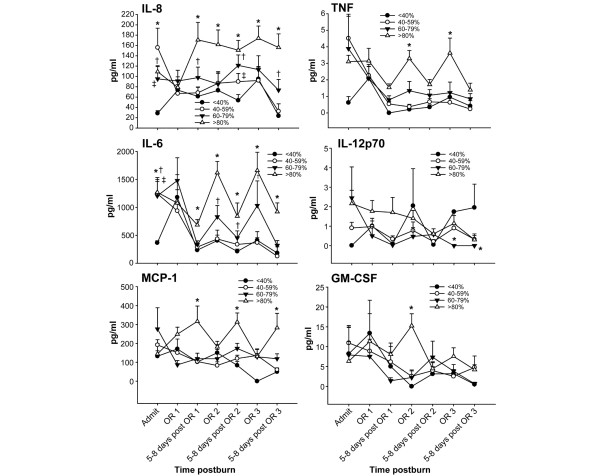
Cytokine concentrations in relation to acute hospitalization. Cytokines were measured at admission (Admit), at first surgery (OR1), at 5–8 days postsurgery 1, at second surgery (OR2), at 5–8 days postsurgery 2, at third surgery (OR3), and again at 5–8 days postsurgery 3. Six cytokines out of 17 measured were significantly different between different burn sizes. Serum IL-8, TNF, IL-6, IL-12p70, monocyte chemoattractant protein-1 (MCP-1) and granulocyte–macrophage colony-stimulating factor (GM-CSF) were significantly increased in the large burns compared with the other three groups. *Significant difference between >80% TBSA burn group versus 60–79%, 40–59% and <40% TBSA burn groups, P < 0.05. †Significant difference between 60–79% TBSA burn group versus 40–79% and <40% TBSA burn groups, P < 0.05. ‡Significant difference between 40–59% TBSA burn group versus <40% TBSA burn group, P < 0.05. Normal levels: IL-8, 7.6 ± 3.9 pg/ml; TNF, 0.7 ± 0.07 pg/ml; IL-6, 8.7 ± 4.9 pg/ml; IL-12p70, 0 ± 0 pg/ml; MCP-1, 42 ± 5 pg/ml; and GM-CSF, 0 ± 0 pg/ml.